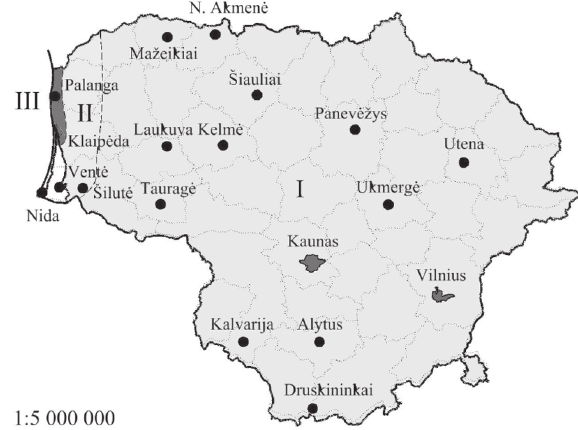
Fig. 5. The map of basic reference wind speeds v ref,d specified in the design code STR 2.05.04:2003 (see also Table 2)